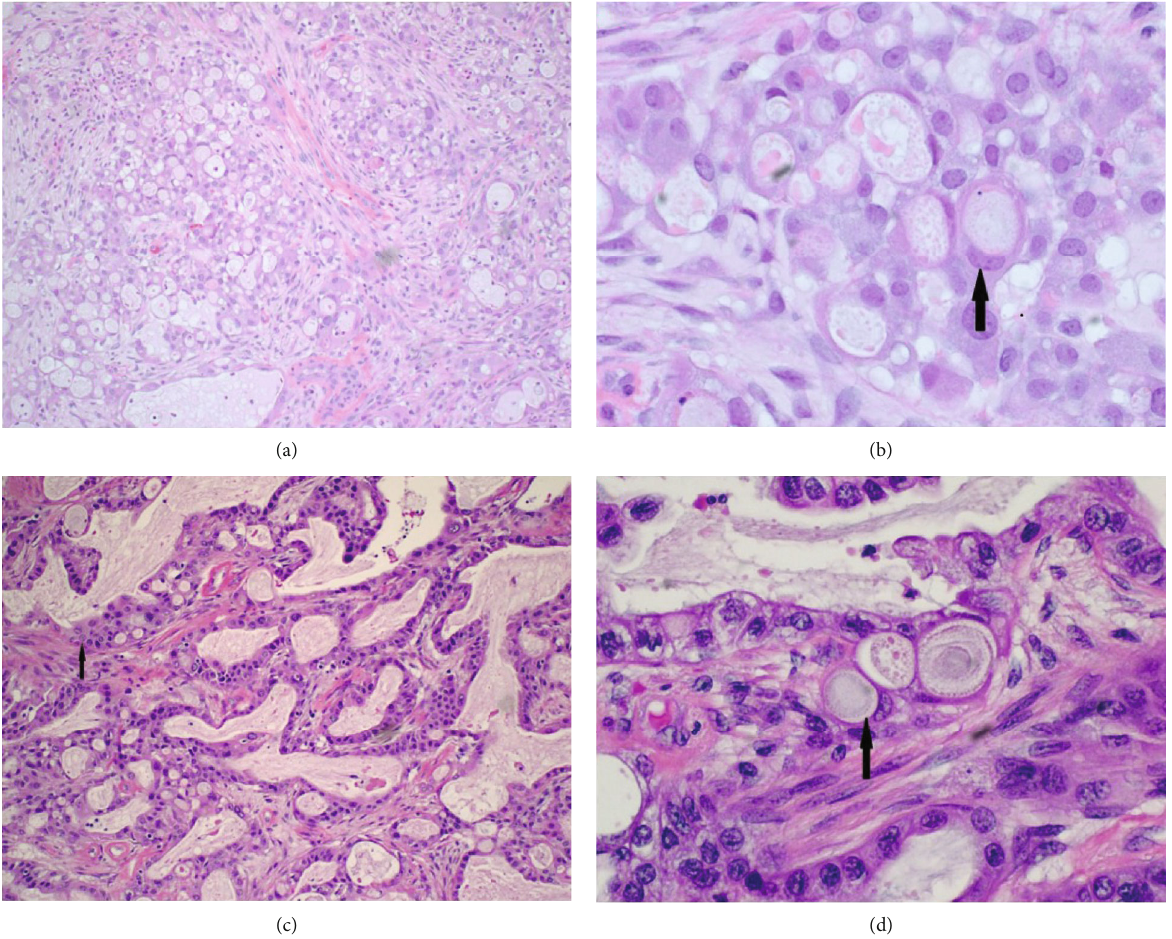
Figure 1: (a) Pretreatment biopsy containing sheets of malignant glandular cells. (b) Higher power magni fi cation where the vast majority of tumor is composed of signet-ring adenocarcinoma cells (arrow). (c) Postsurgical biopsy demonstrating a mixture of conventional mucinous adenocarcinoma (arrow). (d) Postsurgical biopsy demonstrating residual signet cell adenocarcinoma